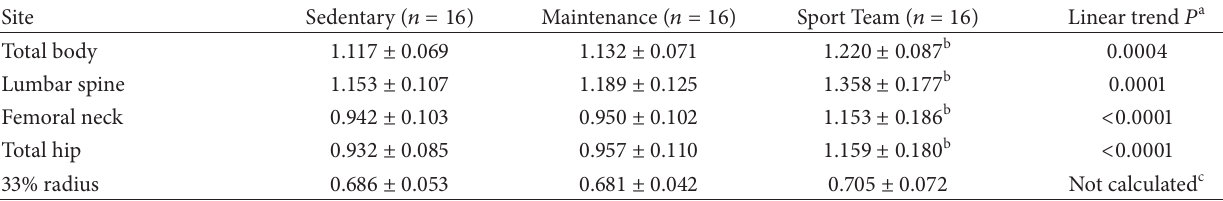
Table 3: Bone mineral density results.